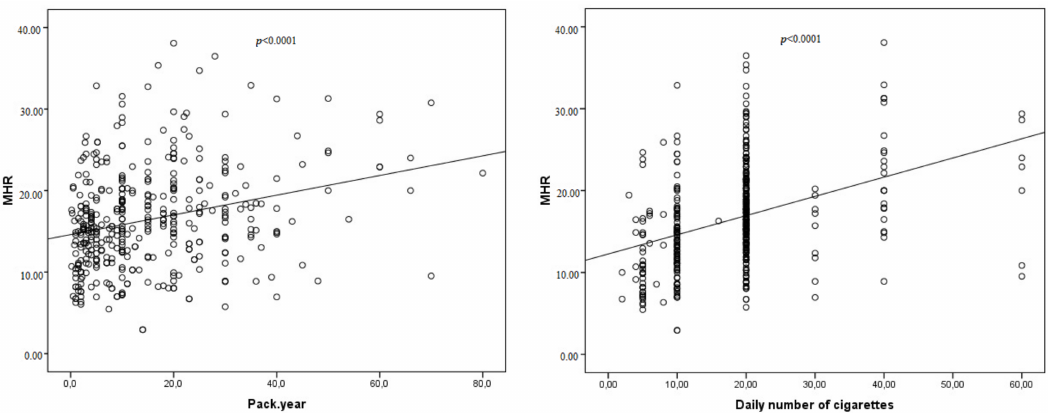
Figure 2. Correlations between MHR and duration of smoking ( A ) and number of cigarettes per day ( B ) in